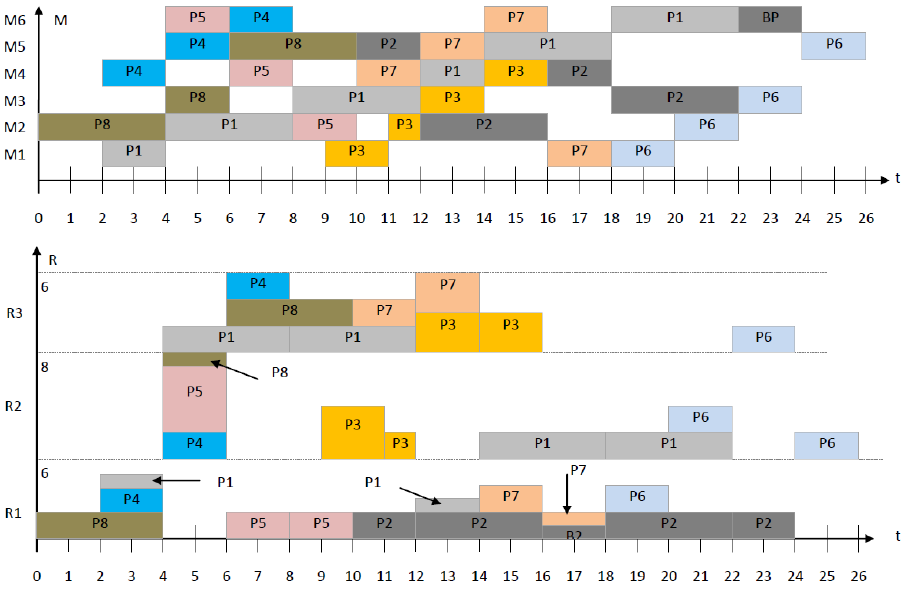
Fig. 7. Gantt charts which visualize the answer to the question Q 12 (upper one: the allocation of machines and lower one: the use of additional resources).